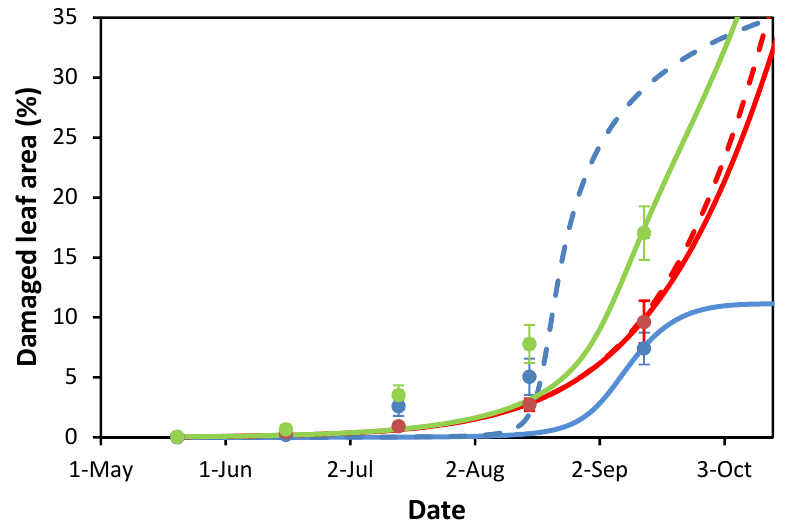
Figure 2. Damage caused by C. ohridella ( blue ) and G. aesculi ( red ) or combined ( green ) averaged over the eight sampling sites so that each dot represents the average ( ± 2SEM) of 240 leaves. Full lines show the damage when both species are present, while the dashed lines show the expected damage of a species in absence of the other. The lines were calculated by means of Equation (3) using the values of α , β and γ given in Table 3, and with p (0) equal to 5.489 × 10 − 5 for C. ohridella and 5.278 · 10 -4 for G. aesculi .